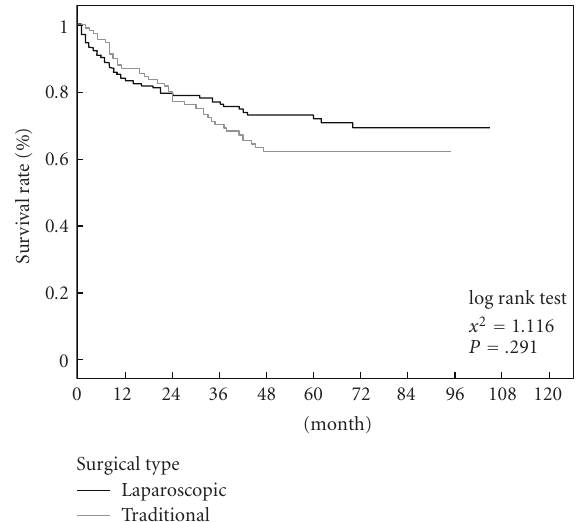
Figure 1: The survival curve of patients with HCC was treated by laparoscopic or open liver resection. Open method had the better result after 24 months postoperatively, but there was no significant di ff erence totally ( P = .